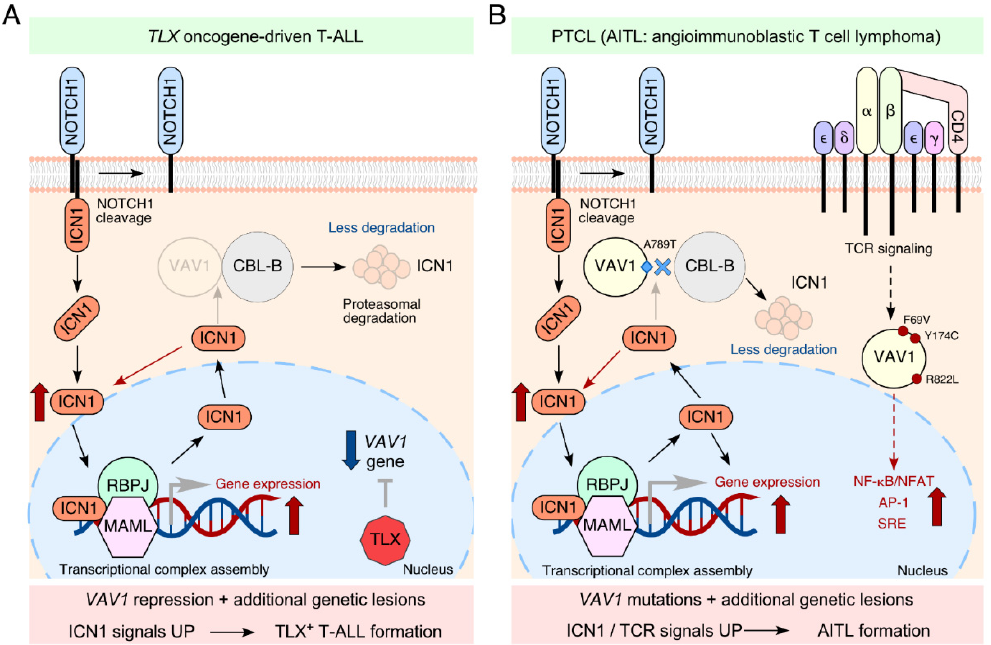
Figure 2. The tumor suppressor activity of VAV1 in T cell neoplasms. ( A ) In human TLX+ T-ALL, the aberrant expression of TLX proteins leads to the transcriptional repression of VAV1 gene and the upregulation of ICN1 signaling. See further details in main text. ( B ) The presence of VAV1 gene mutations that causes the expression of a nonfunctional or absent CSH3 domain might account for the deletion of the tumor suppressor pathway and the increase of ICN1 levels in human PTCLs. We hypothesize that the concurrent engagement of VAV1-dependent canonical routes and ICN1 pathways might play a critical role in T cell transformation. In PTCLs, VAV1 mutations are found at amino acids of the Ac (Tyr 174 ), PH (Lys 404 ), ZF (Glu 556 ) and CSH3 (Arg 798 and Arg 822 ) domains. Furthermore, all the truncations and fusions are targeting the CSH3 domain (i.e. VAV1-MYO1F and VAV1-S100A7). VAV1 mutations in PTLCs are reviewed in [32]. Examples of deficient (unable to bind CBL-B) and gain-of-function (hyperstimulation of RAC1 and NFAT pathways) mutations are shown as blue diamonds and red circles, respectively.